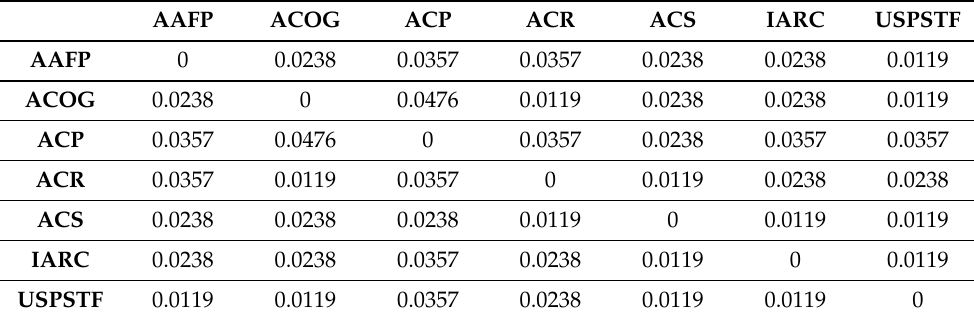
Table 3. Normalized distances between the summarized guidelines computed using Jaccard distances from Tables 1 and